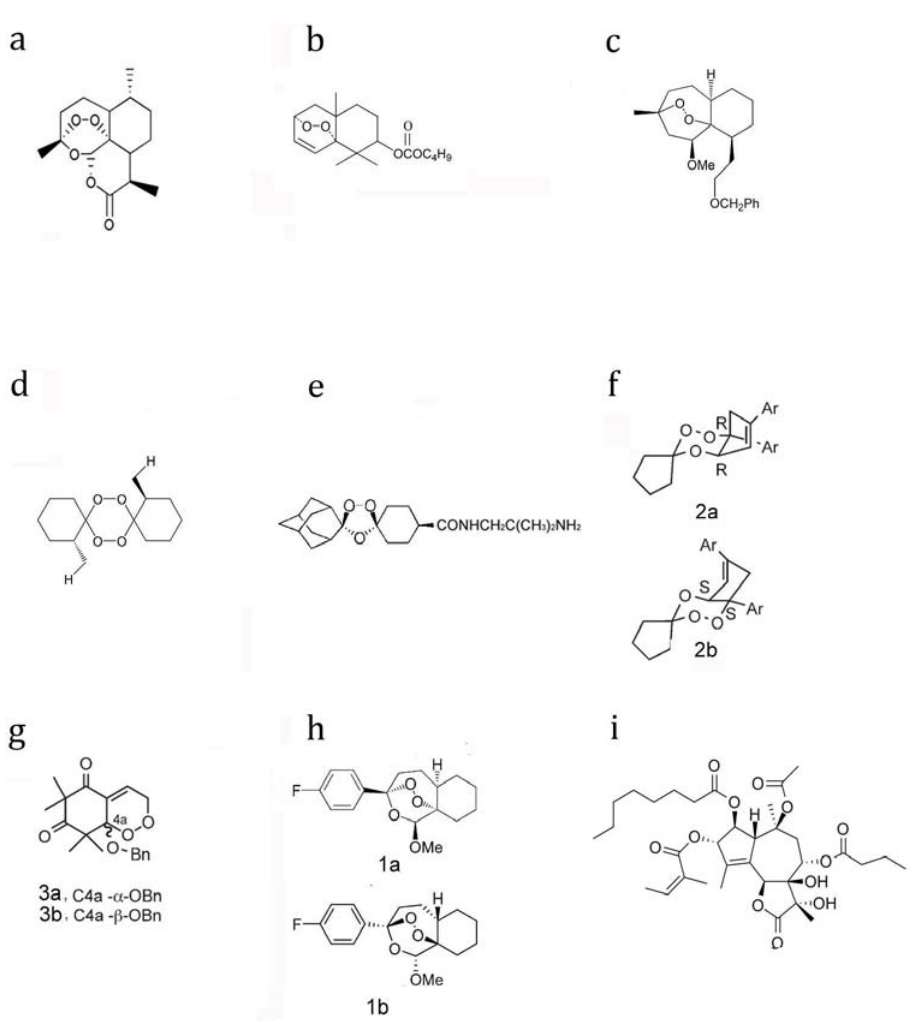
peroxide with less antimalarial potency. (c) An analogue with close structure to artemisinin. (d) An antimalarial tetraoxane. (e) OZ277. (f, g and h) Enantiomers with similar activities against malaria parasites. ( i )